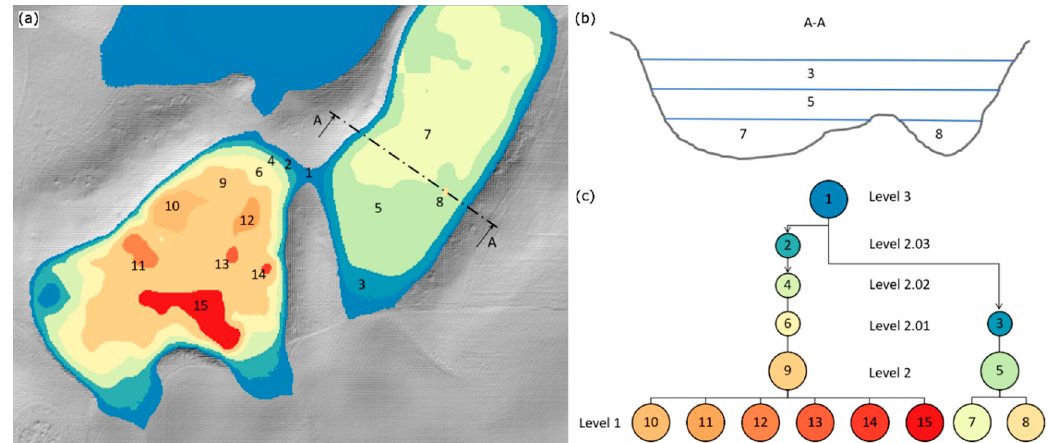
Figure 2. Schematic representation of the Hierarchical Filling-&-Spilling method: ( a ) nested- depression system, and ( b ) blue-spots G and H under fully-filled conditions with illustration of the second-level depressions (F, C, D and E) and third-level depressions (A and B); panels ( c ) and ( d ) report the hierarchical tree of the nested depression systems on the left and the right hand side, respectively, by using different colors for different vertical hierarchical order (adapted from [23]).